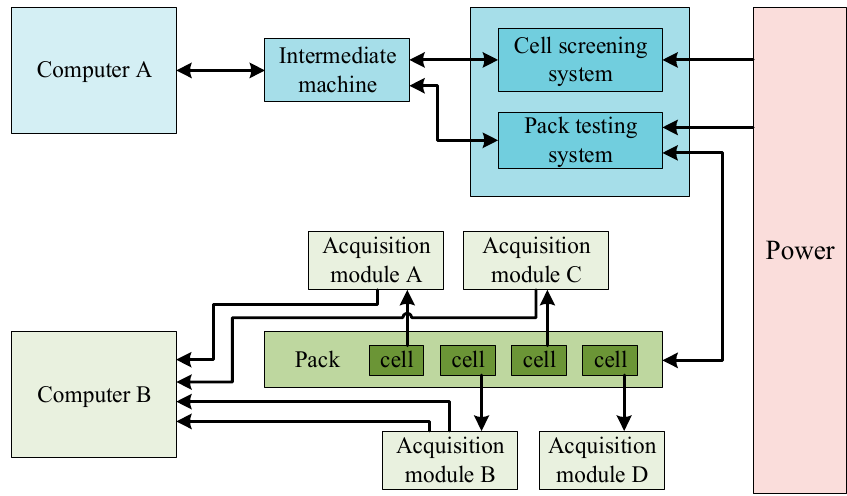
Figure 8. Schematic diagram of the battery pack experiment platform.